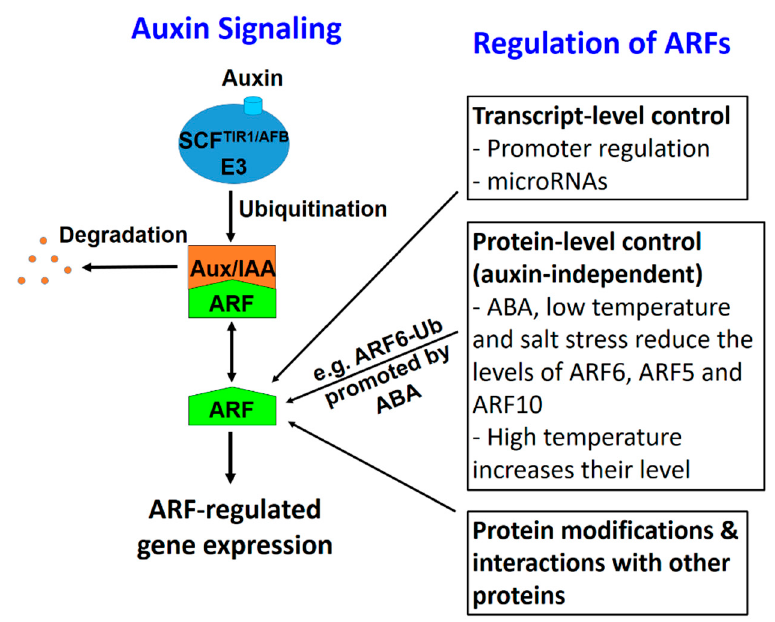
Figure 8. A schematic diagram to show di ff erent types of regulation on ARFs, which can integrate multiple signals into the auxin signaling cascade. In auxin signaling, the binding of auxin stabilizes the interaction between the SCF TIR1 / AFB E3 complex, resulting in the ubiquitination and degradation of Aux / IAA proteins, which frees ARFs. The ARFs function to activate or suppress ARF-regulated genes. ARFs can be regulated at di ff erent levels. Results from this study reveal particularly that several factors can regulate ARF protein levels, likely through auxin-independent mechanisms. ABA, low temperature, and salt stress reduce the levels of certain ARFs while 37 ◦ C temperature increases their levels. Furthermore, ABA promotes ARF6 ubiquitination.